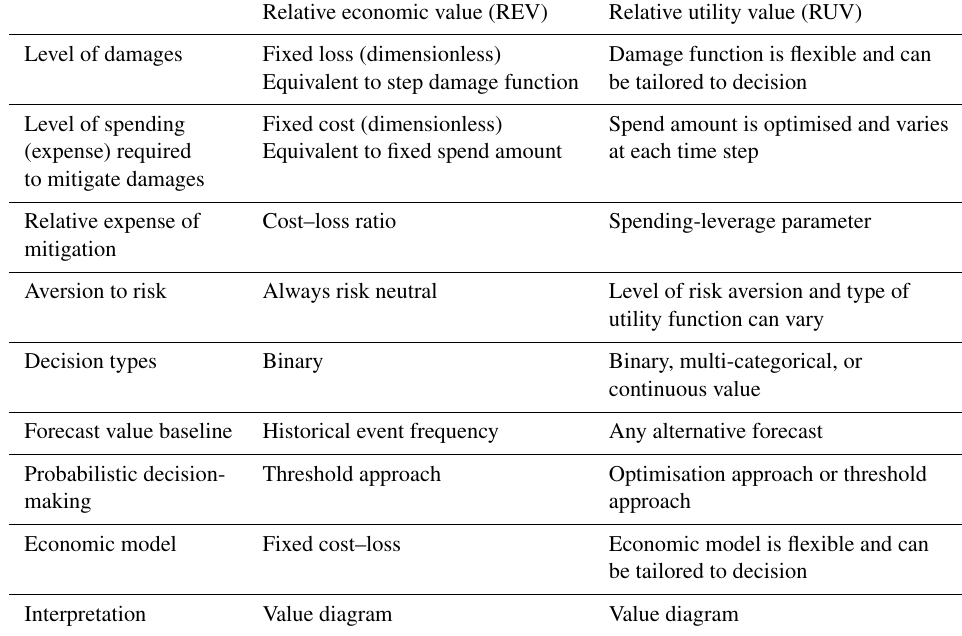
Table 2. Comparison of REV and RUV forecast value methods for defining decisions and user characteristics. Relative economic value (REV) Relative utility value (RUV) Level of damages Fixed loss (dimensionless) Damage function is flexible and can Equivalent to step damage function be tailored to decision Level of spending Fixed cost (dimensionless) Spend amount is optimised and varies (expense) required Equivalent to fixed spend amount at each time step to mitigate damages Relative expense of Cost–loss ratio Spending-leverage parameter mitigation Aversion to risk Always risk neutral Level of risk aversion and type of utility function can vary Decision types Binary Binary, multi-categorical, or continuous value Any alternative